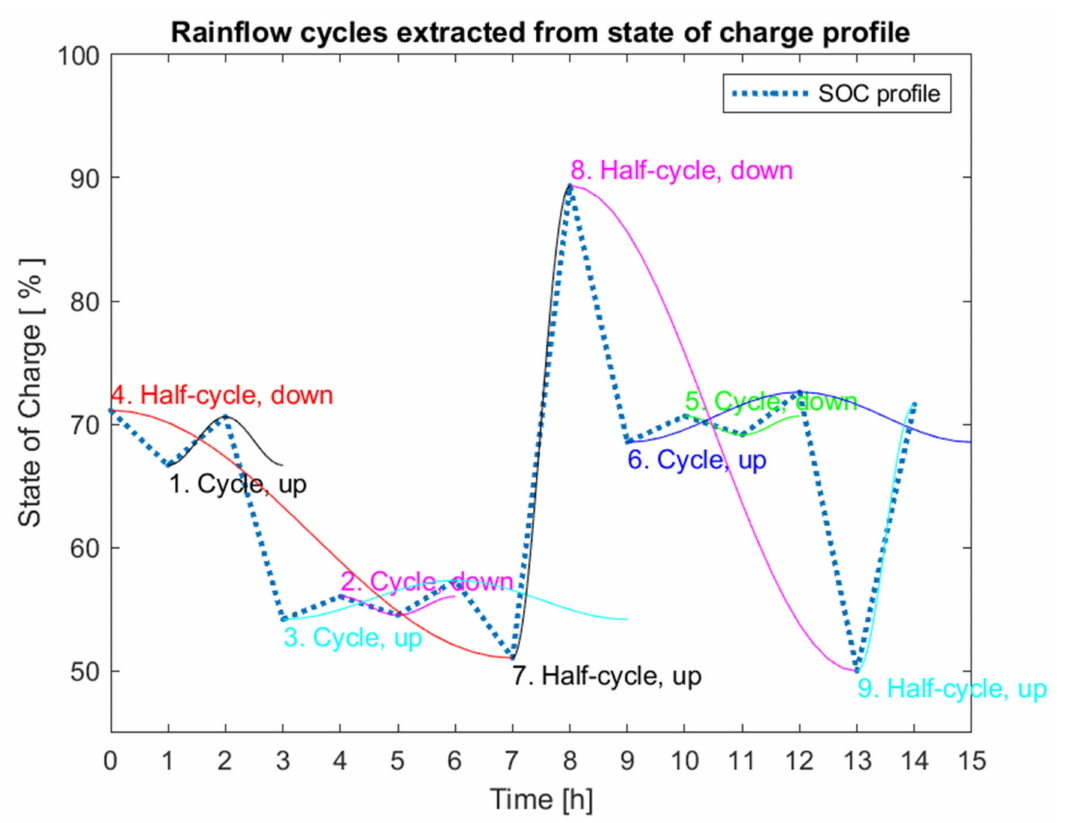
Figure 13. Estimation of charge–discharge cycle extraction of the BSS using state of charge